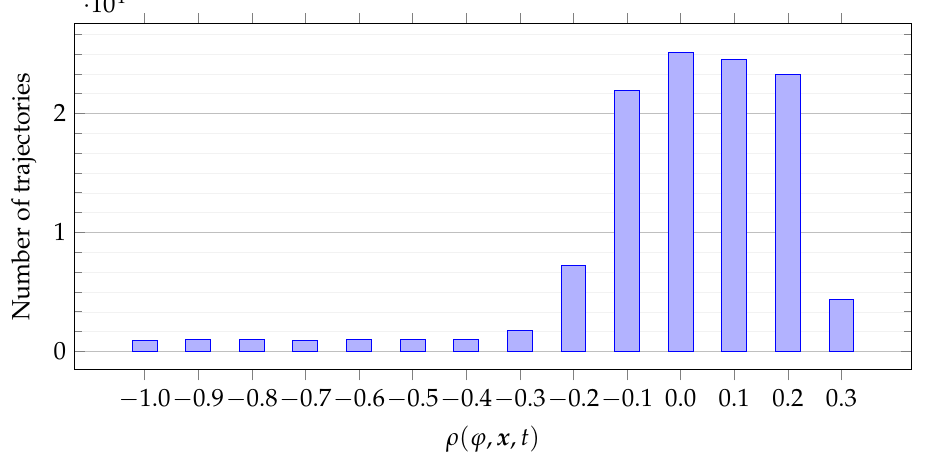
Figure 5. Distribution of the robustness ρ ( ϕ , x , t ) , computed for all the I-80 trajectories x , for the best individual ϕ found in each